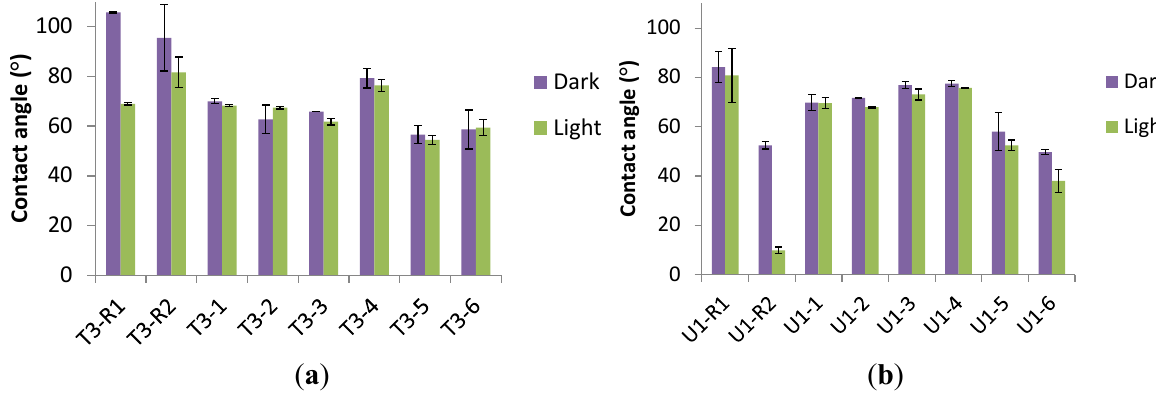
Figure 10. Water contact angle measurements for ( a ) TiO coupons after three month Brewery